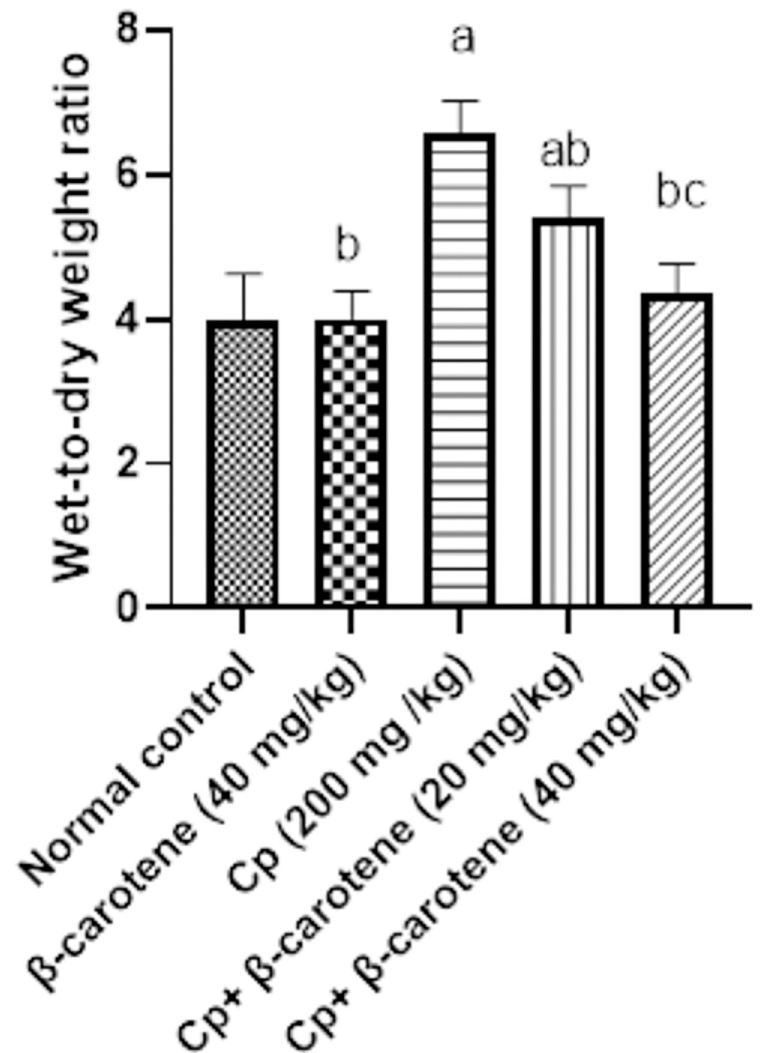
Fig 4. Effect of treatment with β -carotene on wet-to-dry weight (W/D) ratio. a Significantly different from the control group. b Significantly different from the CP group. c Significantly different from the CP + β -carotene 20 mg/kg group at P <